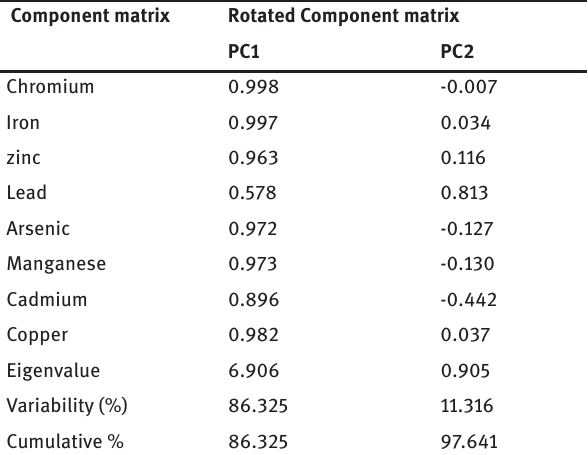
Table 3: Principal component loadings of selected metals in surface water investigated at Ndawuse river and the dumpsite with